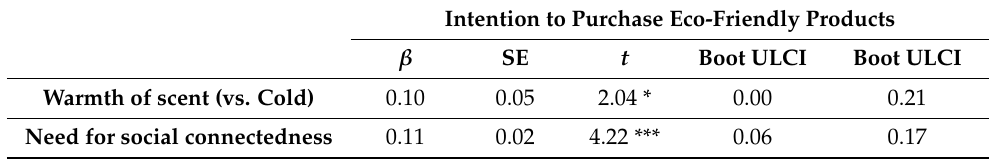
Table 4. Mediation Effect of Inclusion of the Other in the Self in the Relationship between the Experience of Warmth and Intentions toward Prosocial Behavior. 95% Confidence Interval Bootstrap Mediating Factors Indirect Effects Standard Error Boot ULCI Boot ULCI Inclusion of the 0.04 0.01 0.02 other in the self